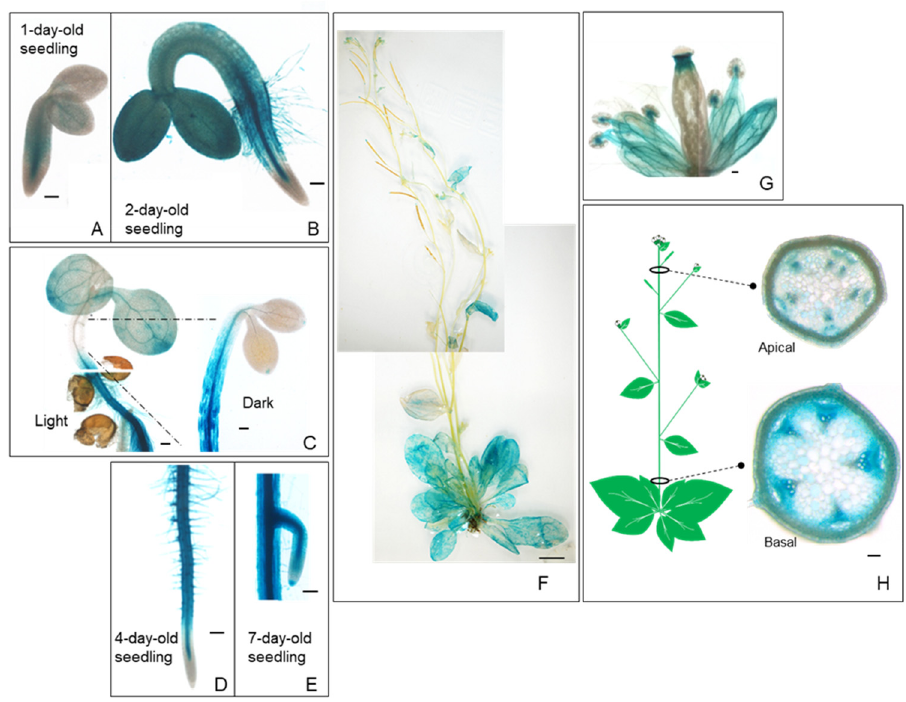
Figure 1. Spatial and temporal expression patterns of pPLAIII γ gene in Arabidopsis. Histochemical analysis of GUS expression harboring PropPLAIII γ ::GUS at different developmental stages. ( A ) 1 ‐ d ‐ old seedling. ( B ) 2 ‐ d ‐ old seedling. ( C ) Aerial part of 4 ‐ d ‐ old seedlings grown under long day (16 h light/8 h dark) and dark conditions. ( D ) Root of 4 ‐ d ‐ old seedlings. ( E ) The meristematic zone of the lateral root in 7 ‐ d ‐ old seedlings. ( F ) 6 ‐ week ‐ old whole plant. ( G ) Floral organs. ( H ) The cross ‐ sections show the GUS expression in the vasculature of the apical and basal parts of the stem. Scale bars = 100 μ m (A–E, G, and H) and 1 cm (F).